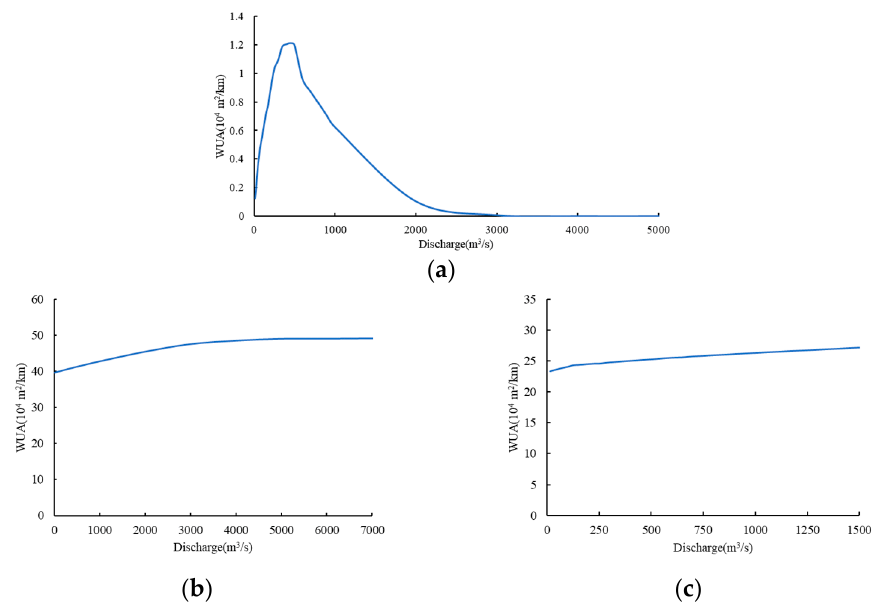
Figure 5. Variation of WUA with the discharge flow: ( a ) spawning period; ( b ) feeding period; ( c ) overwintering period.